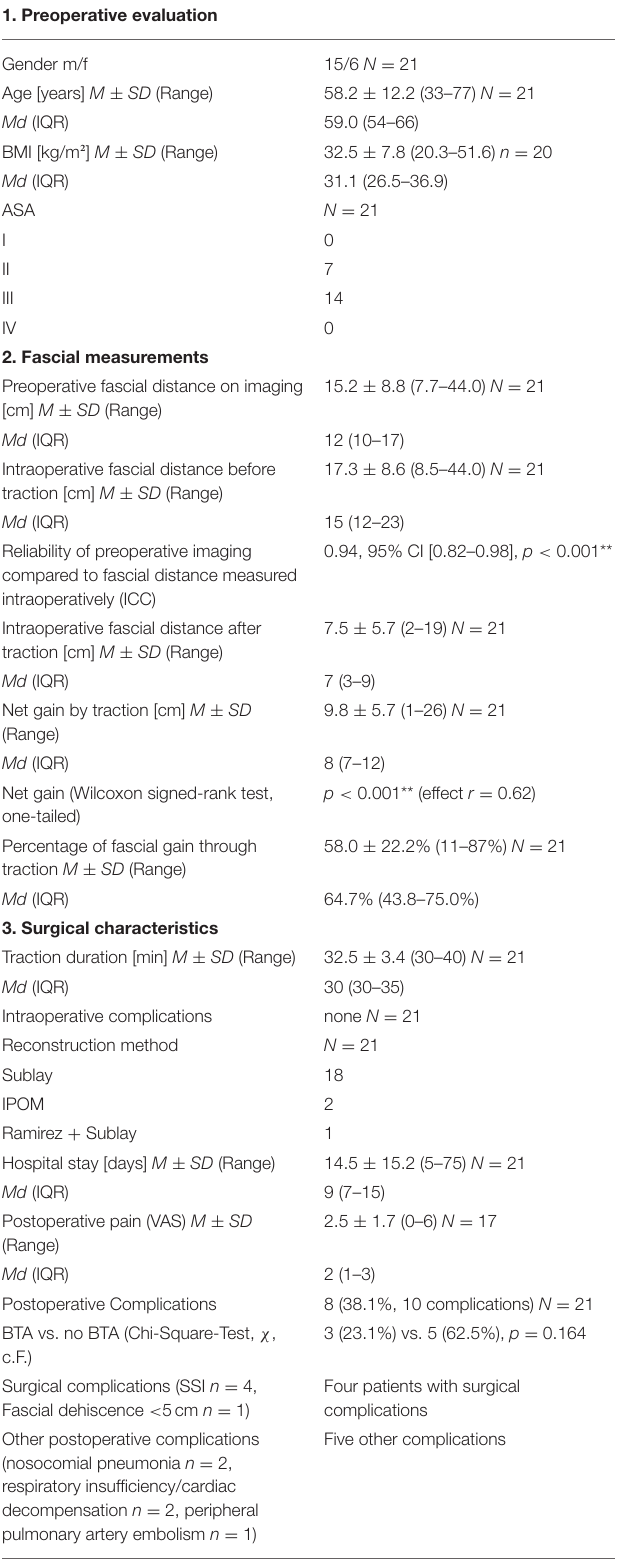
TABLE 1 | Patient characteristics, measurements and statistical analysis ( N =